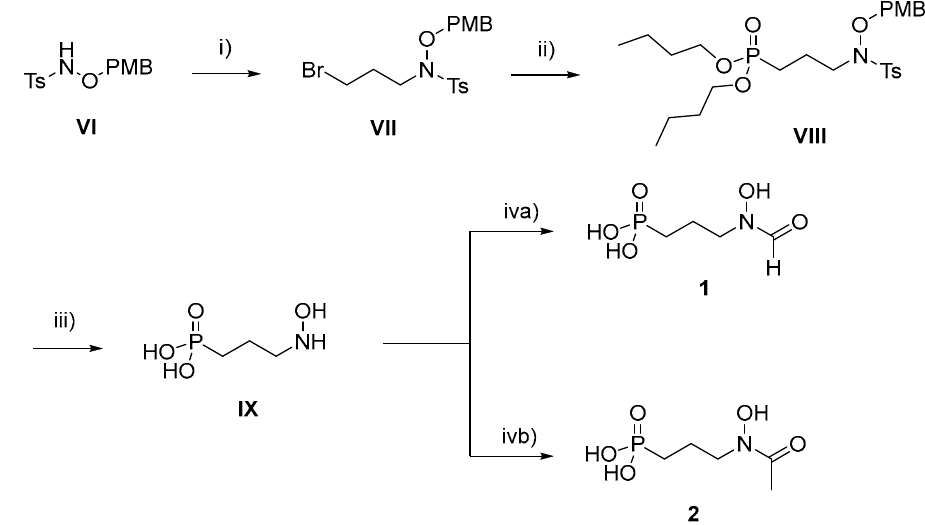
Figure 2 . Additional phosphono-hydroxamic acids published by the Fujisawa Pharmaceutical Co. Ltd. [21]